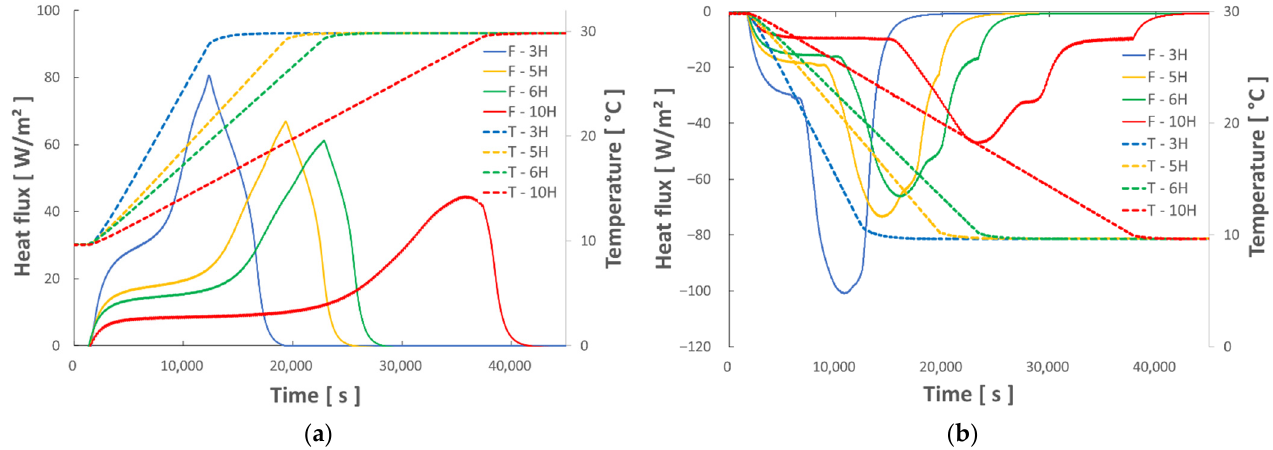
Figure 12. Evolution of the heat flux (F–xH) exchanged between the plate and the sample, for various temperature ramps (T–xH): melting phase ( a ), and solidification phase ( b ).